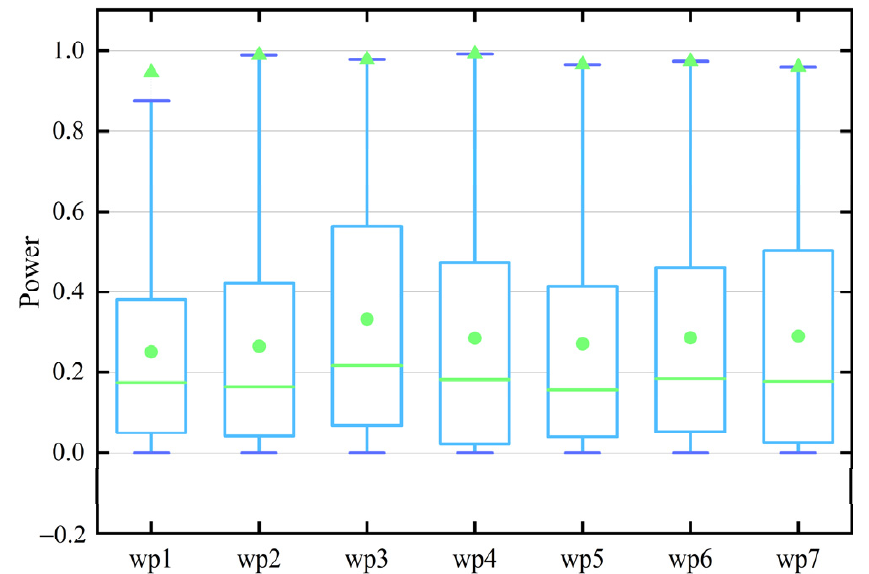
Figure 2. The wind power data characteristics of 7 wind farms. The green triangles and circles represent the outliers and the average values of the data set respectively. The short purple lines on the upper side represent the maximum values, while those on the lower side represent the minimum values. And the short green lines represent the median values.